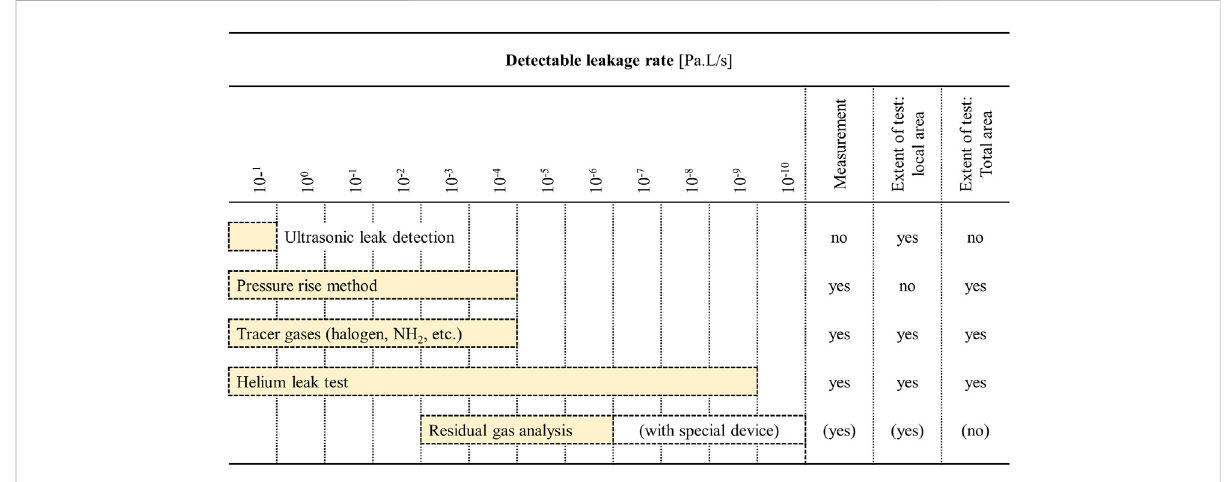
FIGURE 3 Applicationsanddetectionlimitsofvariousleakdetectionandleaktightnesstestingmethodsundervacuum.Thedetectionlimitsspeci fi edhere should only be regarded as reference values, since the true detection limits will depend on the conditions under with the test is performed. Adapted from Schroder (2001).